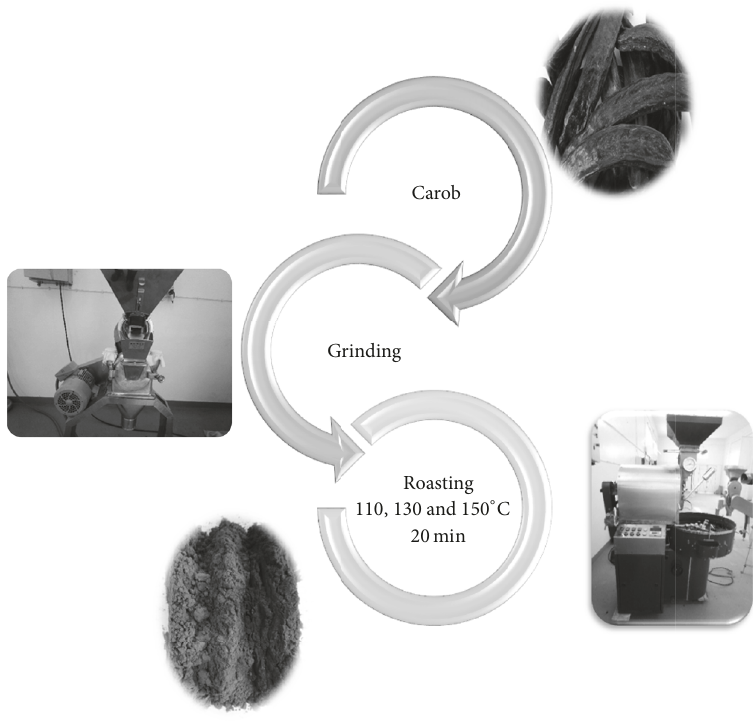
Figure 1: Roasting process of carob